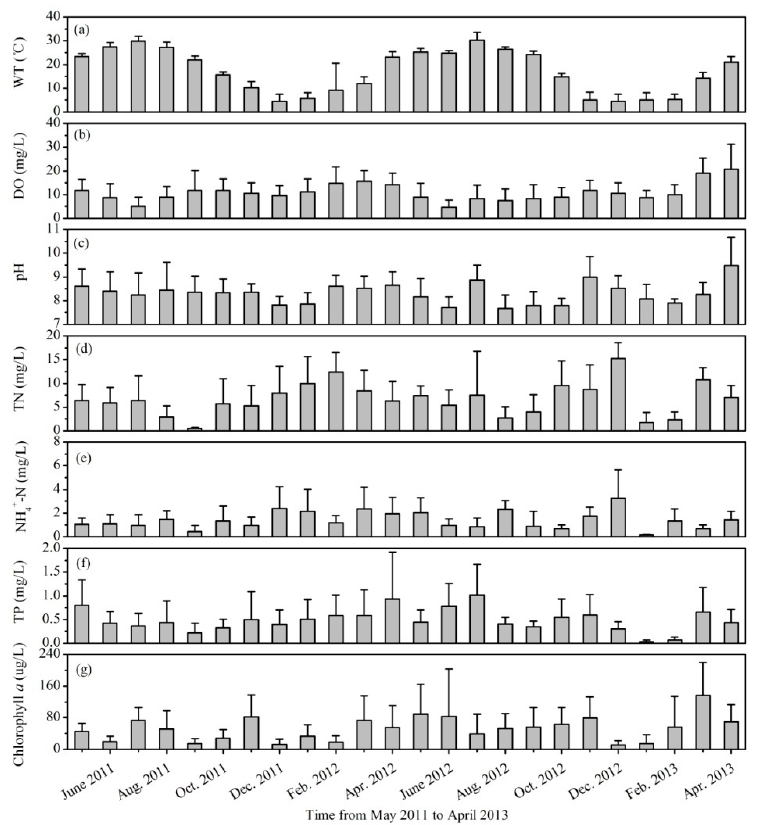
Figure 2. Combined variations of ( a ) water temperature (WT); ( b ) dissolved oxygen (DO); ( c ) pH; ( d ) total nitrogen (TN); ( e ) ammonia nitrogen (NH 4+ ‐ N); ( f ) total phosphorus (TP); and ( g ) chlorophyll a in different months in Lake Qixinghu. The environmental factors in each month are expressed as mean values and standard deviations of the 23 sample sites in the lake.